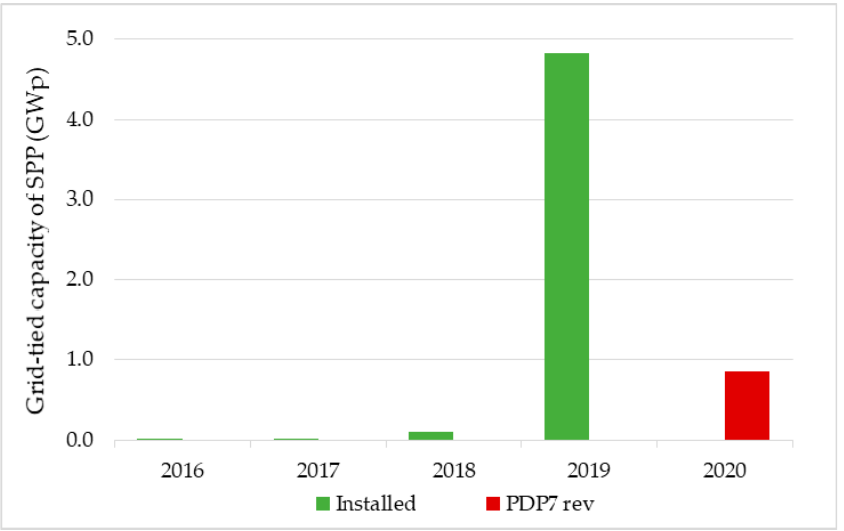
Figure 10. Total capacity of grid-tied SPPs by 2019 and in Power Development Plan 7 revised.